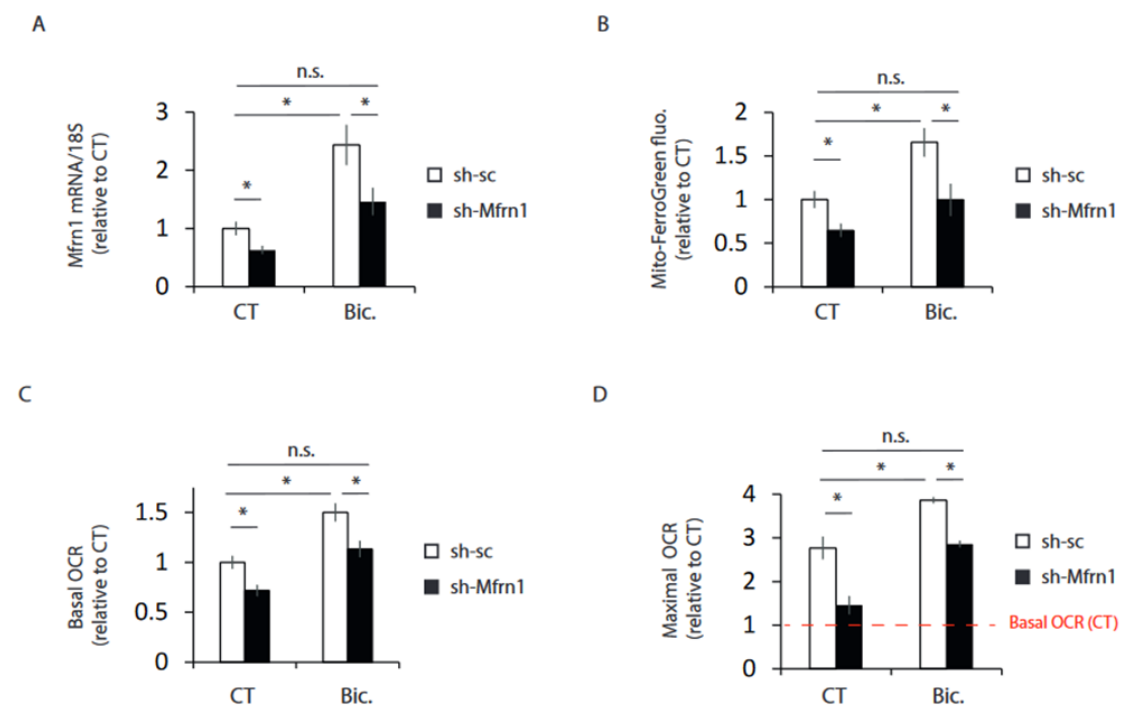
Figure 4. Mfrn1 knockdown impairs mitochondrial bioenergetics. Neurons transduced with AAV expressing shRNA targeting Mfrn1 (shMfrn1) or control non-targeting shRNA (shsc). ( A ) After 4 h stimulation with Bic, Mfrn1 mRNA expression was determined by qPCR (n = 6 independent experiments). ( B ) Mitochondrial ferrous content was analyzed in control, and 24 h stimulated neurons transduced with an AAV expressing a shRNA targeting Mfrn1 (shMfrn1) or a non-targeting shRNA (shsc) as indicated (n = 4 independent experiments). ( C ) Basal OCR and ( D ) maximal OCR was determined after 24 h stimulation with Bic (n = 5 independent experiments). The red dashed line indicates basal OCR of resting neurons. * p < 0.05, one-way ANOVA, followed by Tukey’s post hoc test. n.s. = non-significant.